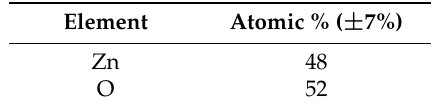
Table 1. Table of the quantitative analysis of the ZnO nanomaterial obtained by Energy-dispersive X-ray (EDX).